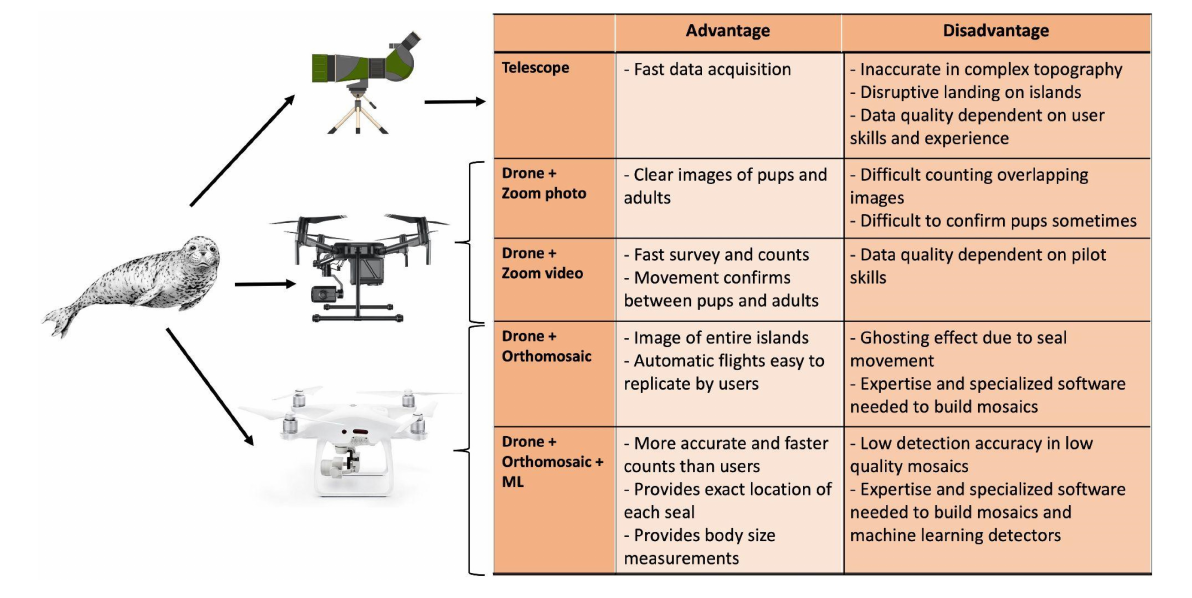
measuring body sizes), while still providing key information on the